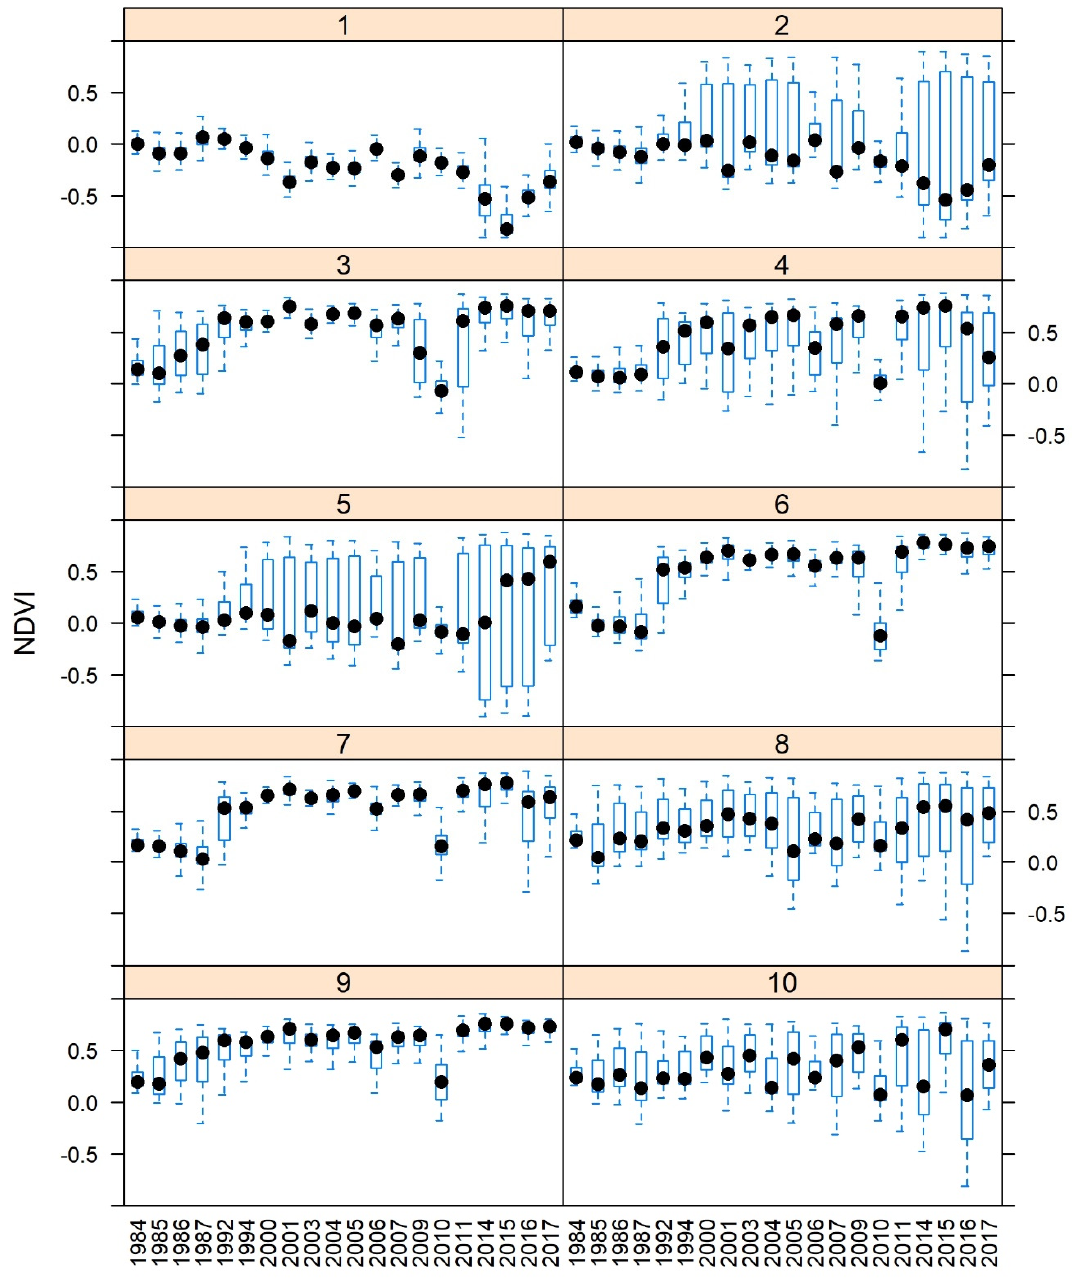
Figure 5. NDVI values for the 10 basins of Lake Tisza between 1984 and 2017.